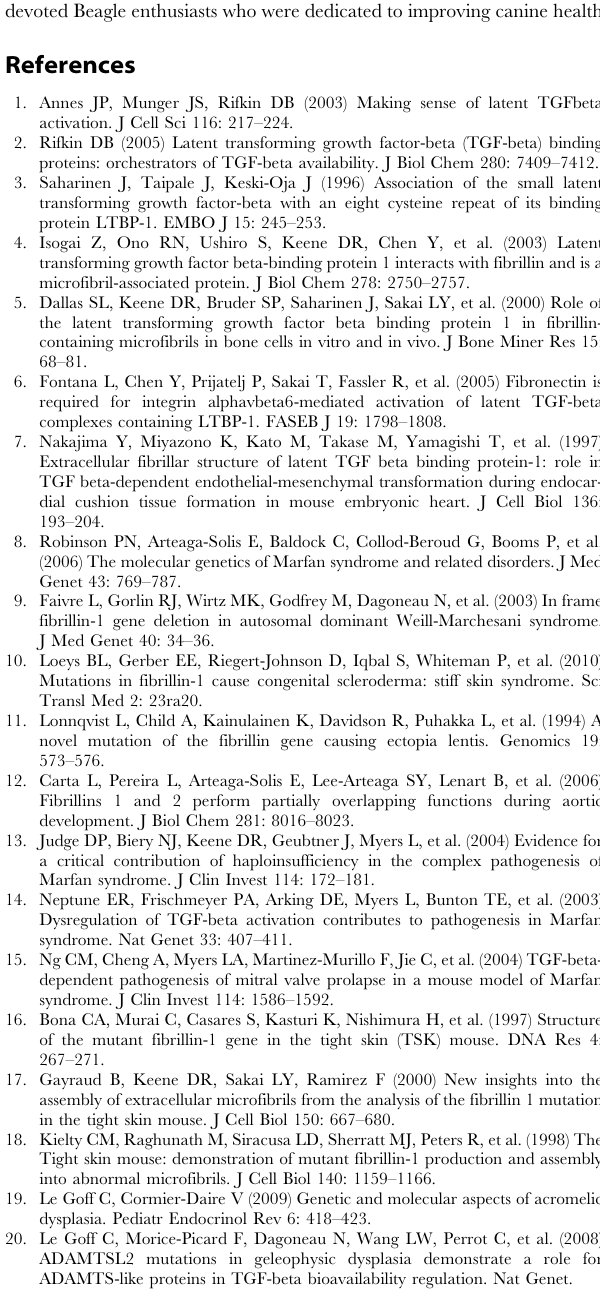
Figure S1 Amino acid alignment of mammalian ADAMTSL2 proteins. Found at: doi:10.1371/journal.pone.0012817.s007 (0.15 MB